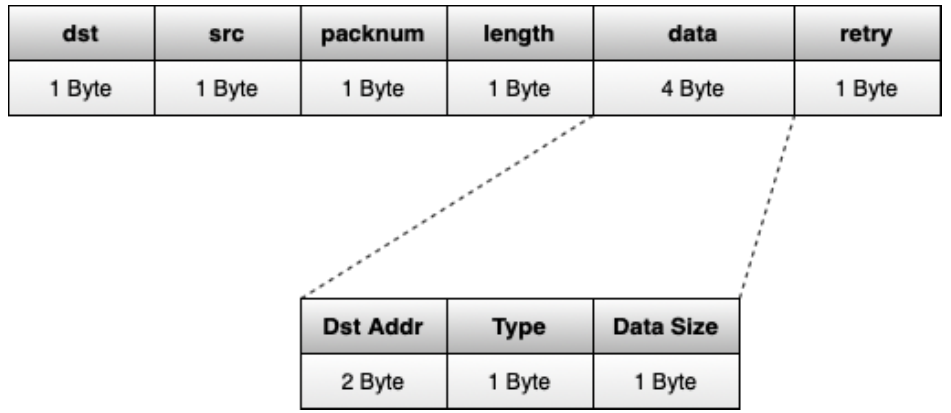
Figure 1. RTS packet structure.